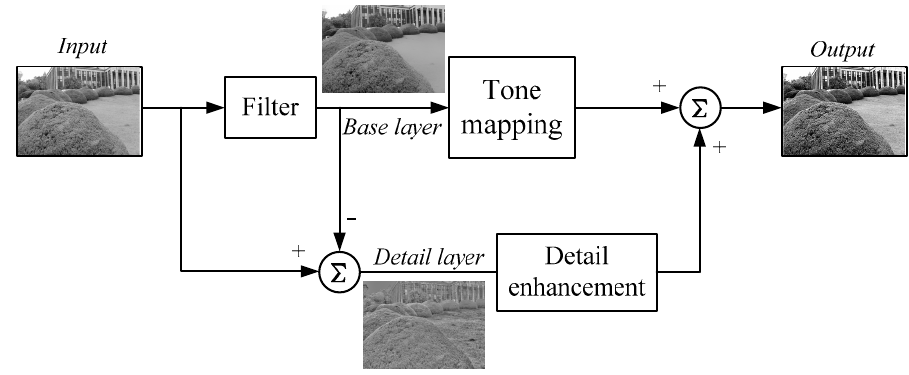
Figure 1. Procedure for image decomposition.